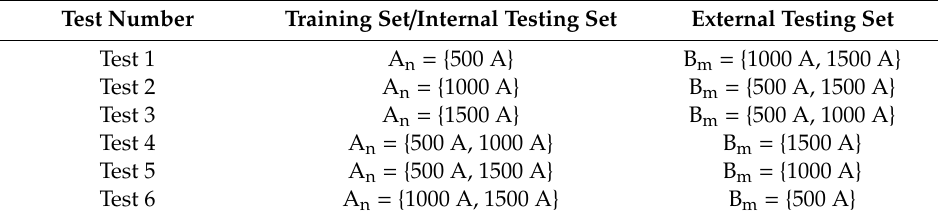
Table 3. Training and testing data set.